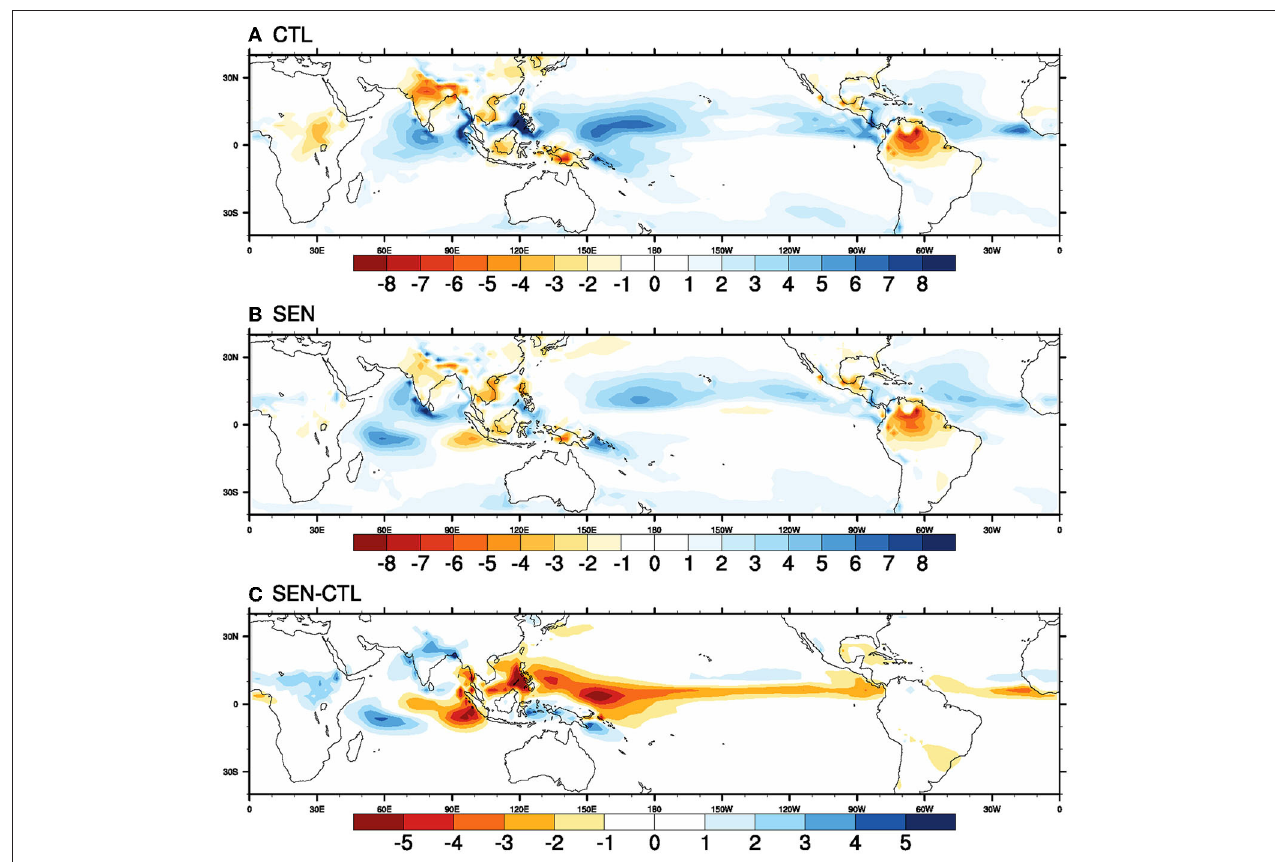
FIGURE 9 | Seasonal (JJAS) mean bias in precipitation rate (mm/day) in (A) CTL run, (B) SEN run, and (C) SEN-CTL for the period of